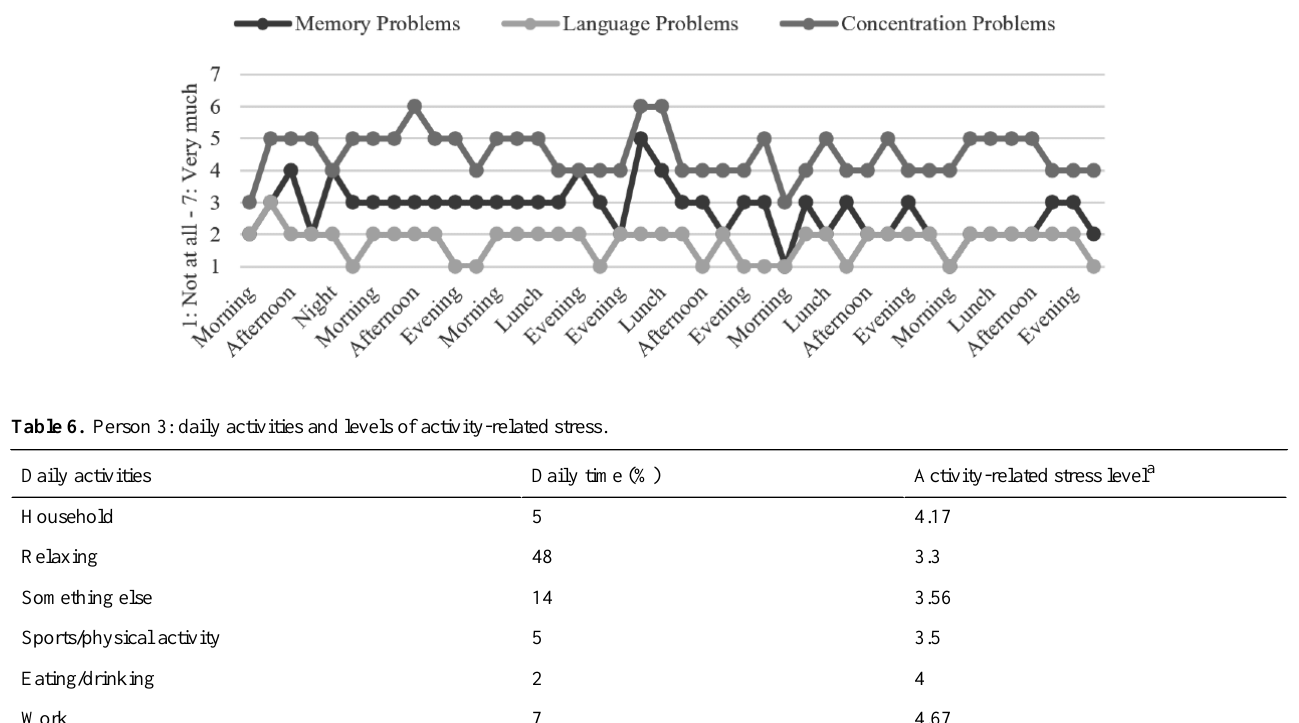
Figure 4. Patient 3: subjectively experienced cognitive problems.